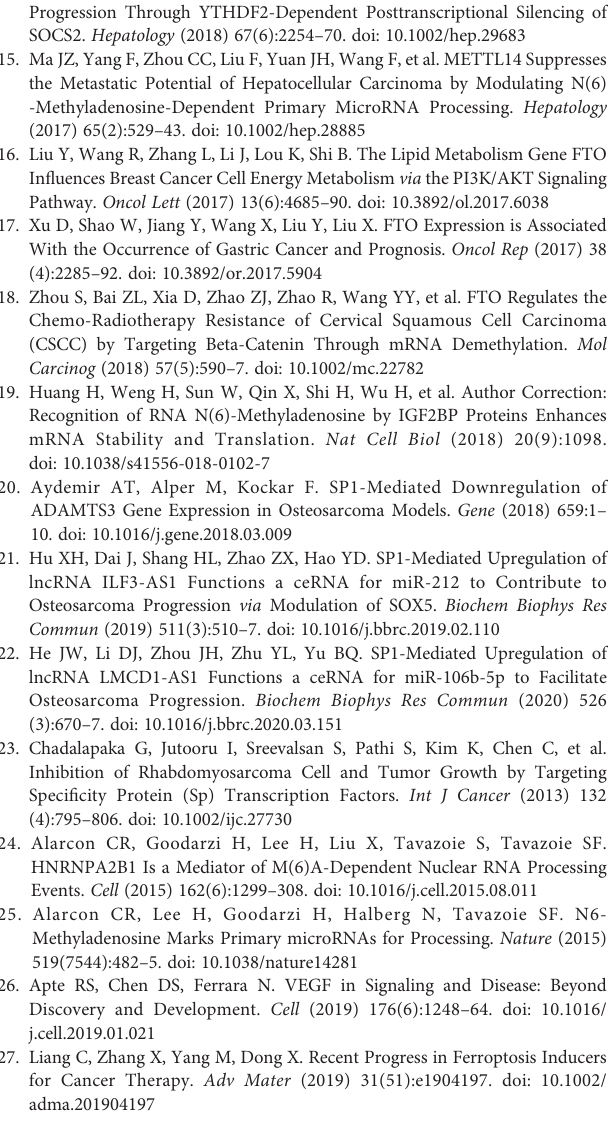
Supplementary Table 1 | Raw clinical data of sarcoma cohorts in TCGA dataset. Supplementary Table 2 | siRNA sequences used in this study. Supplementary Table 3 | Primer sequences used in this